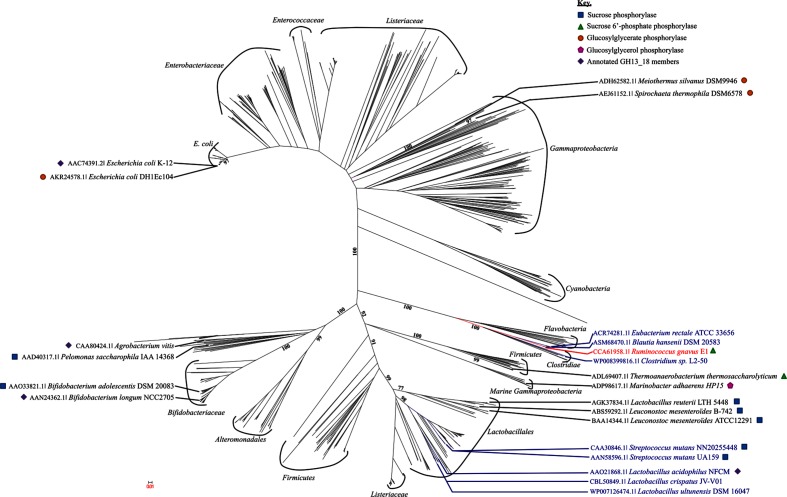
Phylogenic tree of subfamily GH13_18. The tree includes all the GH13_18 listed in the CAZy database. Members sharing syntenies with Rgspp are indicated in dark blue. Enzyme specificity is indicated in the key.